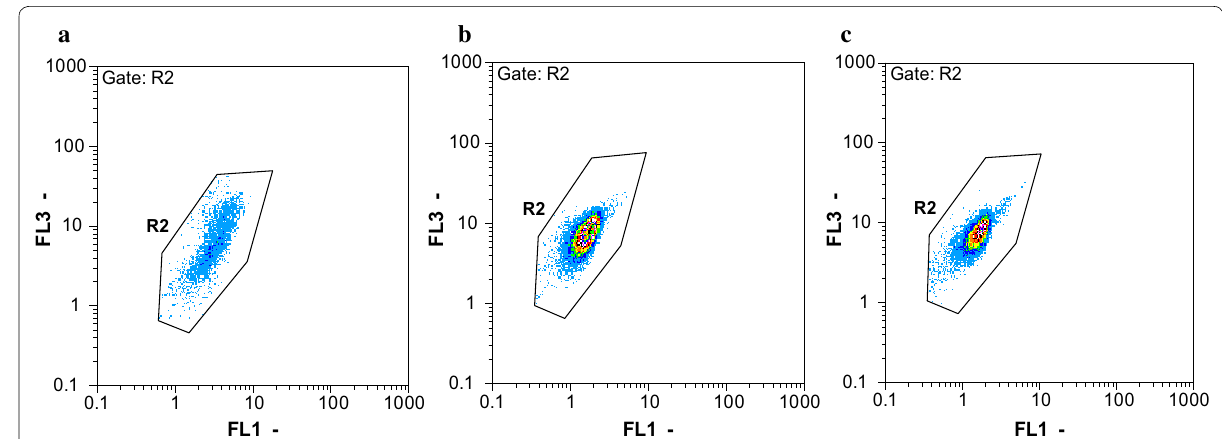
Fig. 2 Examples of flow cytometric dot plots of strain WZN-1 at different time during BDE 209 degradation: a 0 day; b 15 days; c 30 days. FL1 repre- sents green fluorescence was collected at FL1